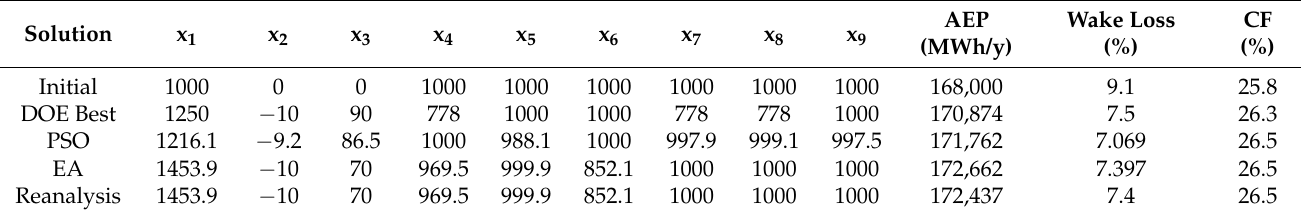
Figure 9. Optimal turbine layout for 12 WTGs at the Gori wind farm. ( a ) initial, ( b ) DOE best solution ( c ) optimal solution. Table 4. Key results summarized from the optimization framework.